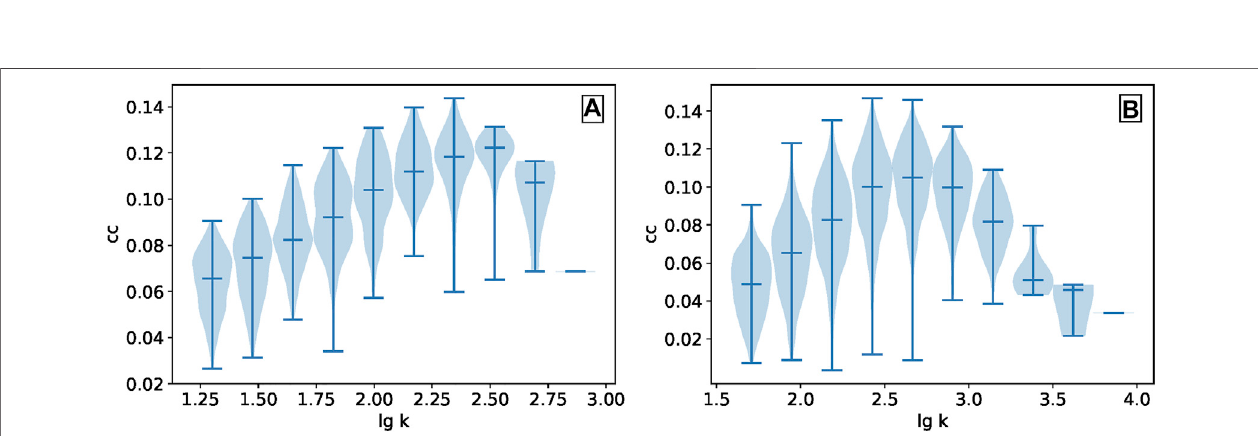
FIGURE 5 | The relationship between the evaluators ’ degree and the clustering coef fi cient in (A) MovieLens and (B) Net fl ix are presented by a violin plot. The evaluators in each dataset are divided into ten bins according to their degrees. The extreme value and median are marked with short bars, and the probability density is represented by